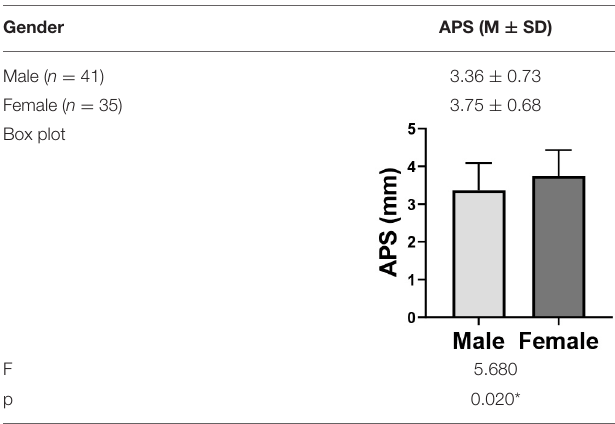
TABLE 6 | One-way ANOVA of of average pupil size between